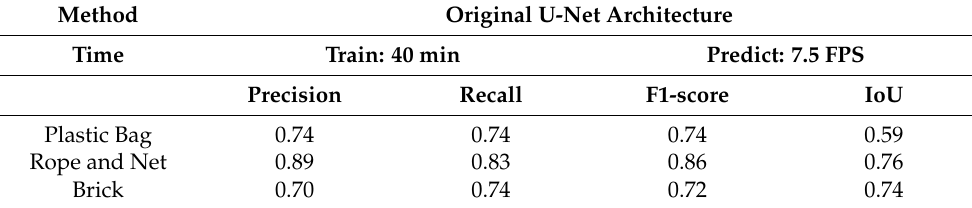
Table 3. Training with original U-Net architecture.